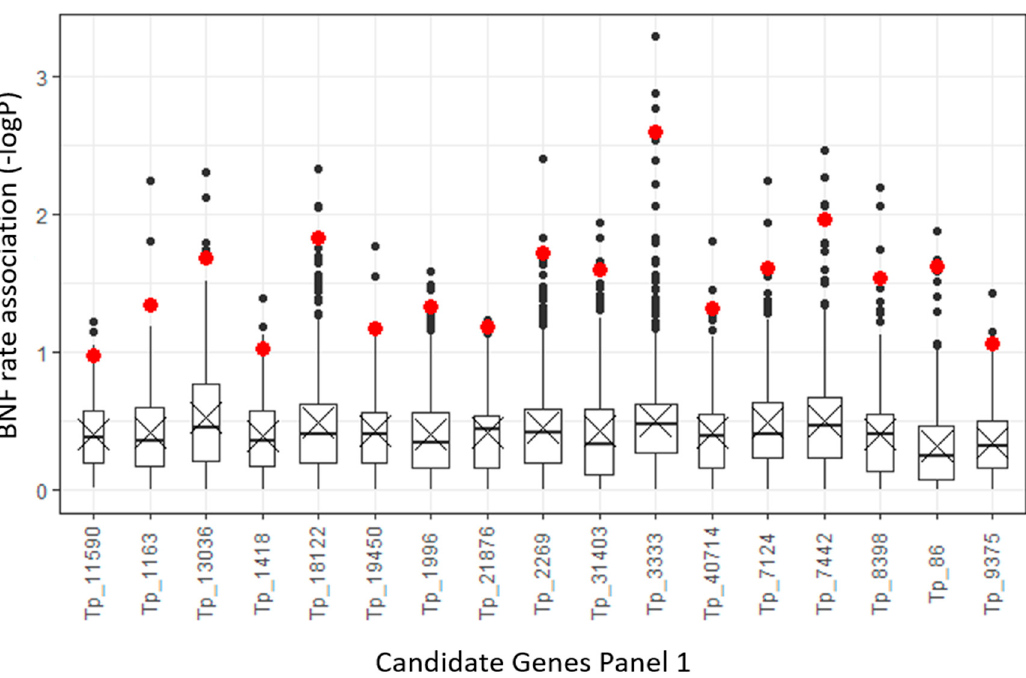
Figure 2. Boxplot of − logP association values for Panel 1 of nitrogen fixation candidate gene polymorphisms based on mixed linear model incorporating both population structure and relationships among accessions. Red dots show mean values for the 10 highest − logP values of each associated polymorphism. The highest mean value was that of Tp_3333, which is the sequence with the ethylene response factor required for nodule differentiation ( EFD ) gene [35].